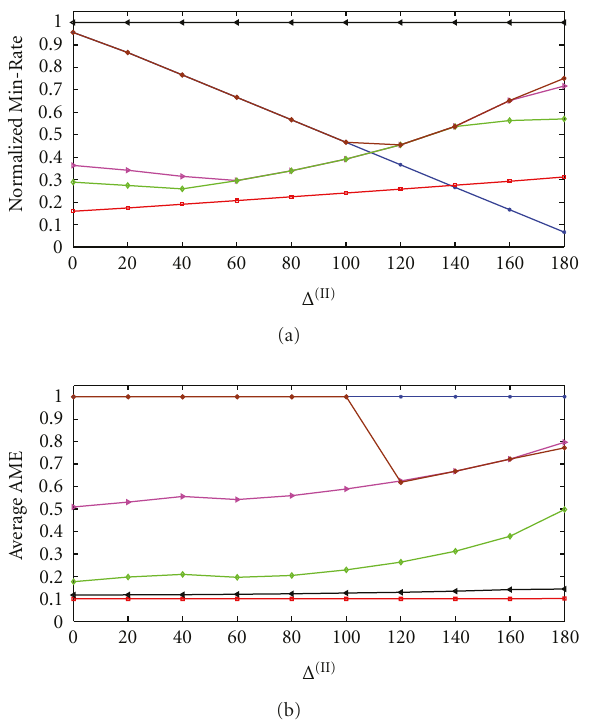
Figure 4: Experimental results for Model III: (a) Normalized Min- Rate versus Δ (III) ; (b) Average AME versus Δ (III) . Note that Δ (III) is not expressed in dB. The number of users ( K ), the number of runs ( N r ), and all graphical conventions are the same like in Figure